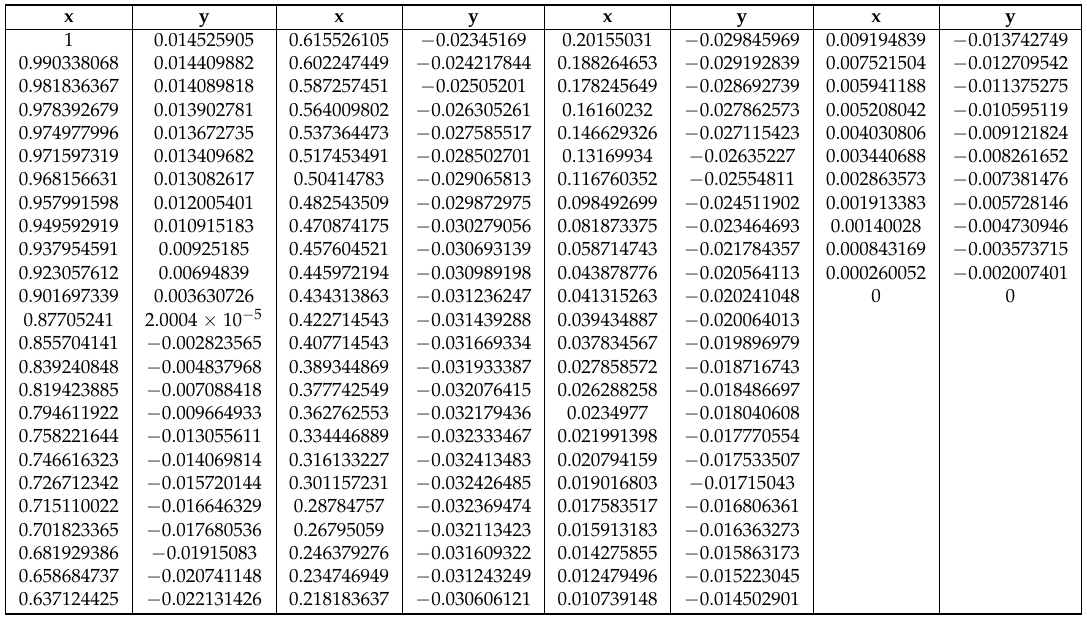
Table A2. The coordinates of the pressure side of the current OA209